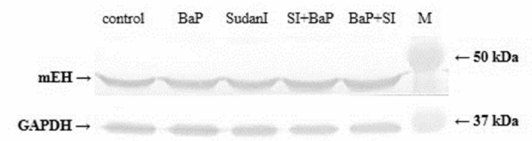
Figure 7. Western blot analysis of mEH in hepatic microsomes isolated from control (untreated) rats and rats exposed to BaP alone, Sudan I alone, Sudan I (SI) before BaP treatment or Sudan I after BaP treatment. GAPDH protein expression was used as a loading control. M—marker of molecular